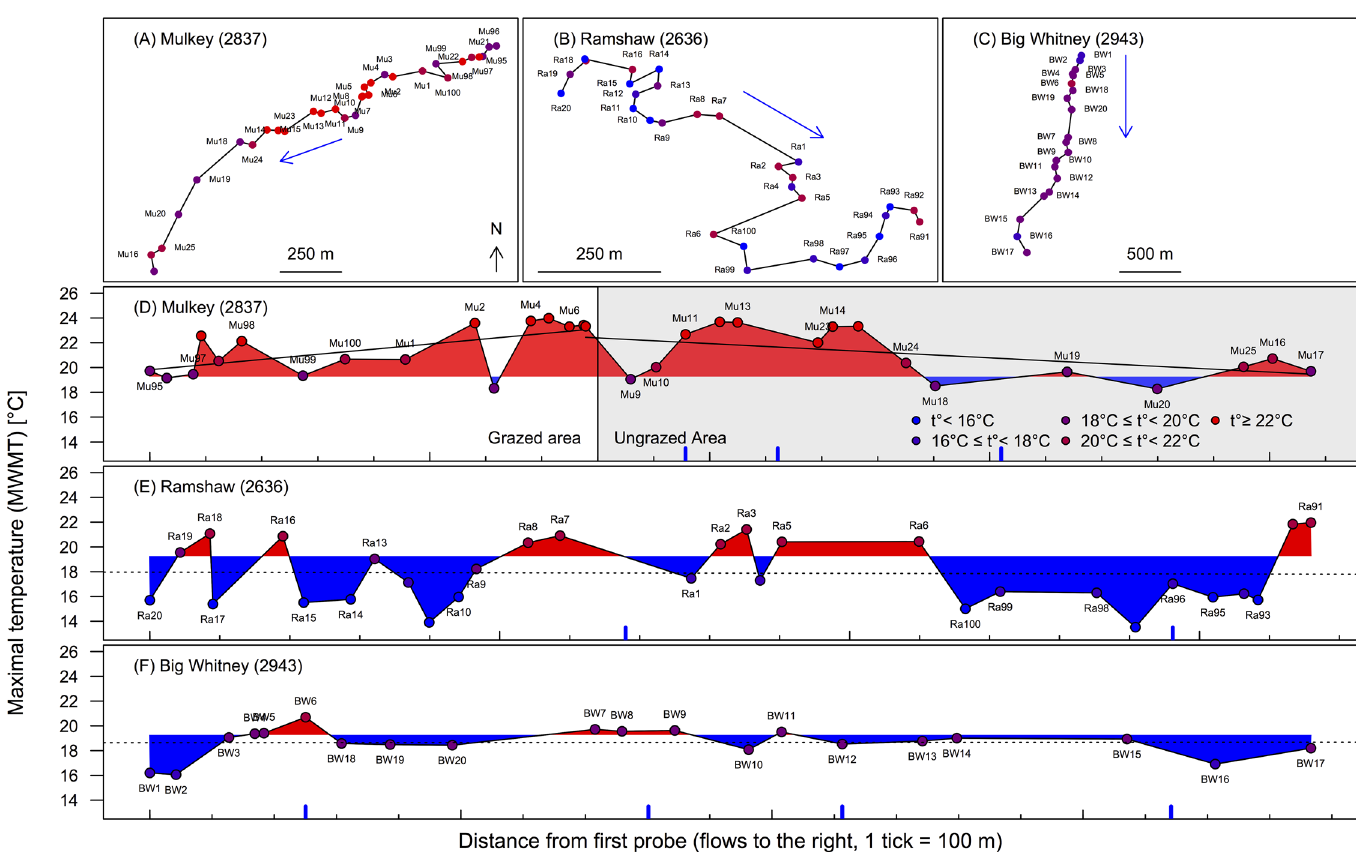
Fig 4. Maxima of the weekly maximal temperature (MWmaxT). The upper three panels (A-C) represent the distribution of the probes along the streambed in each meadow. All three rivers flow from North to South. The color code represents the maximum of the weekly maximal temperature (MWmaxT) in each probe: blue is used to represent probes where temperature never reaches 16°C, violet-blue when the highest temperatures were between 16 – 18°C, violet for 18 – 20°C, red-violet for 20 – 22°C, and red for temperatures higher than 22°C. The three larger panels (D-F) represent the same information with the maximum of the weekly maximal temperature (MWmaxT) on the y-axis and the distance from the first probe on the x-axis. The color code for the dots is the same as in the previous panels (A-C), and the red (blue) coloration between the dots represents whether the temperatures are above (below) the average weekly maximal temperature (WmaxT) observed across the three meadows. The regression lines represent the trends of maximal temperature (MWmaxT) over distance (solid lines are significant, while dashed lines are not). The grey area in Mulkey represents the cattle-exclosure, and the blue lines on the x-axis represent the different tributaries entering the